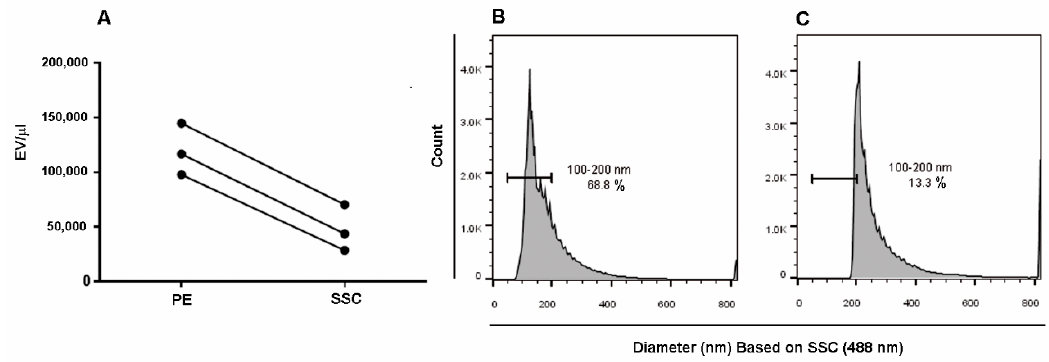
Figure 2. Side scatter (SSC) / phycoerythrin (PE) threshold comparison. ( A ) Three di ff erent MSC-derived Figure 2. S ide scatter (SSC)/phycoerythrin (PE) threshold comparison. ( A ) Three different EV supernatants were acquired using the same gating strategy by placing the threshold on PE or SSC. MSC-derived EV supernatants were acquired using the same gating strategy by placing the Counts obtained by the two triggering strategies were compared using the paired t -test ( p = 0.0005; threshold on PE or SSC. Counts obtained by the two triggering strategies were compared using the 2-tailed). ( B , C ) Dimensional gating encompassing a region of 100–200 nm was drawn on a diameter paired t -test ( p = 0.0005; 2-tailed). ( B , C ) Dimensional gating encompassing a region of 100–200 nm (nm) histogram (FCS files transformed by the Rosetta Calibration system) representing MSC-derived was drawn on a diameter (nm) histogram (FCS files transformed by the Rosetta Calibration system) EVs acquired by thresholding on PE ( B ) or SSC ( C ). representing MSC-derived EVs acquired by thresholding on PE ( B ) or SSC ( C ).